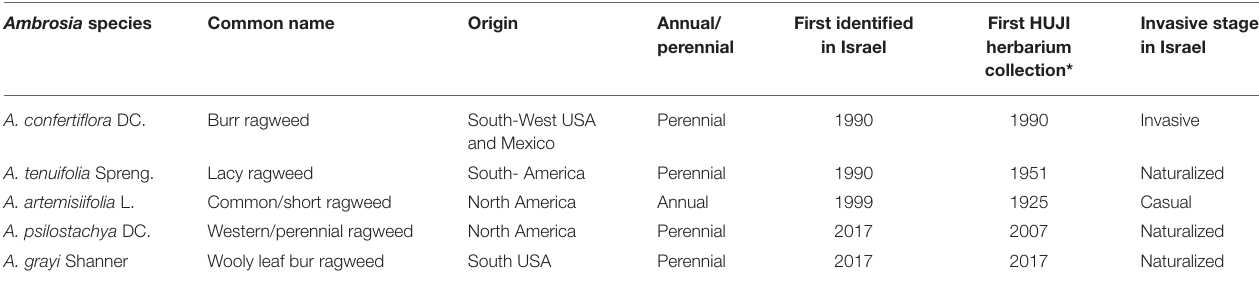
TABLE 1 | Ambrosia species present in Israel and their